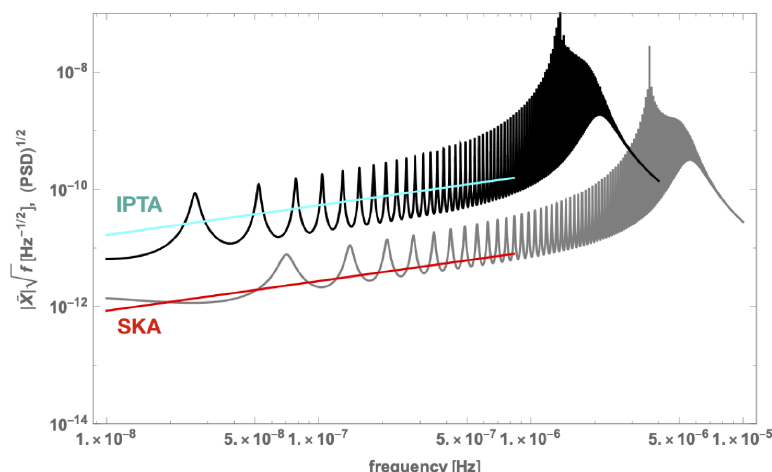
Figure 41. Spectra of GW echoes in the Boltzmann reflectivity model with ¯ a = 0.6, (cid:96) = m = 2, D o = 1 Gpc, and γ = 1. The gray line shows the case of M = 3 black line shows one for M = 8 IPTA (blue) and SKA